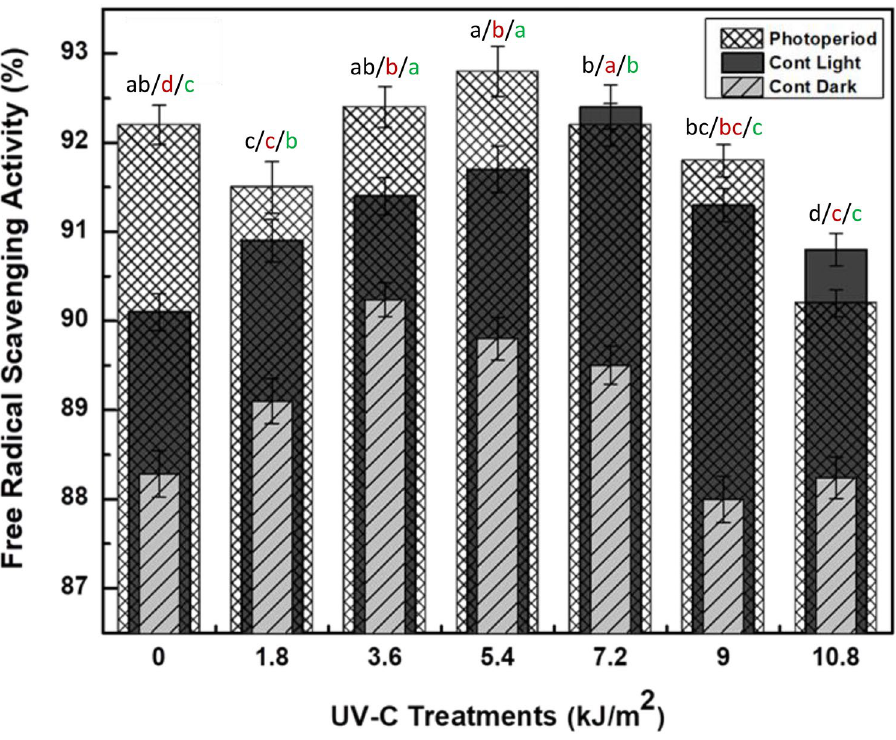
Figure 6. Free radical scavenging activity of UV-C radiations (0–10.8 kJ/m 2 ) mediated callus cultures of Fagonia indica grown in different light regimes [cont. light (24 h), dark (24 h) and photoperiod (PHP, 16L/8D h)]. Values represented as mean ± SE of three replicates. Different (black for UV + PHP, red for UV + cont light, green for UV + dark) letters represent significant differences between the various experimental conditions ( p <